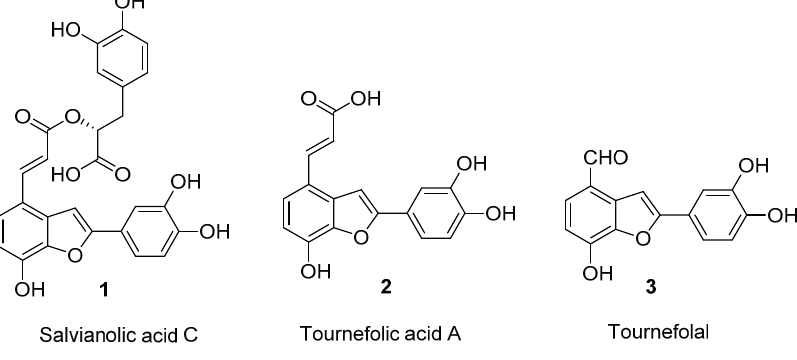
Figure 1. Structures of natural benzofuran antioxidants isolated from Salvi a